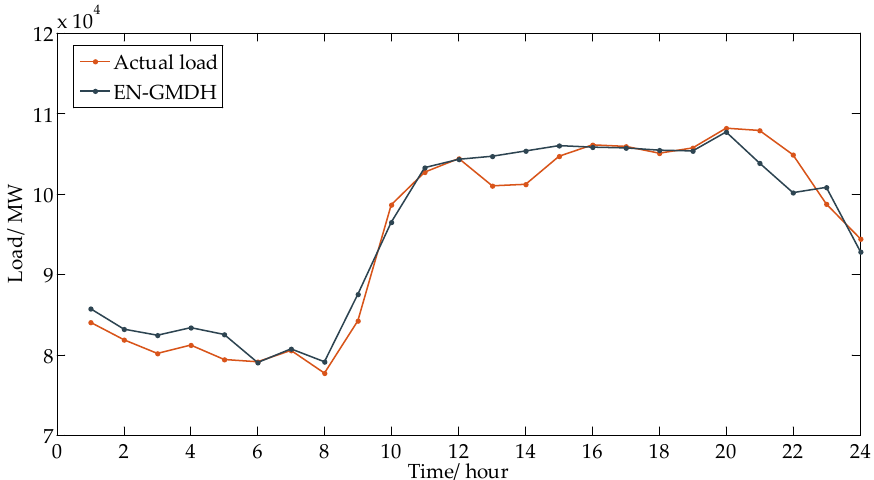
Figure 7. Load forecasting curve. EN-GMDH: Group method of data handling based on elastic